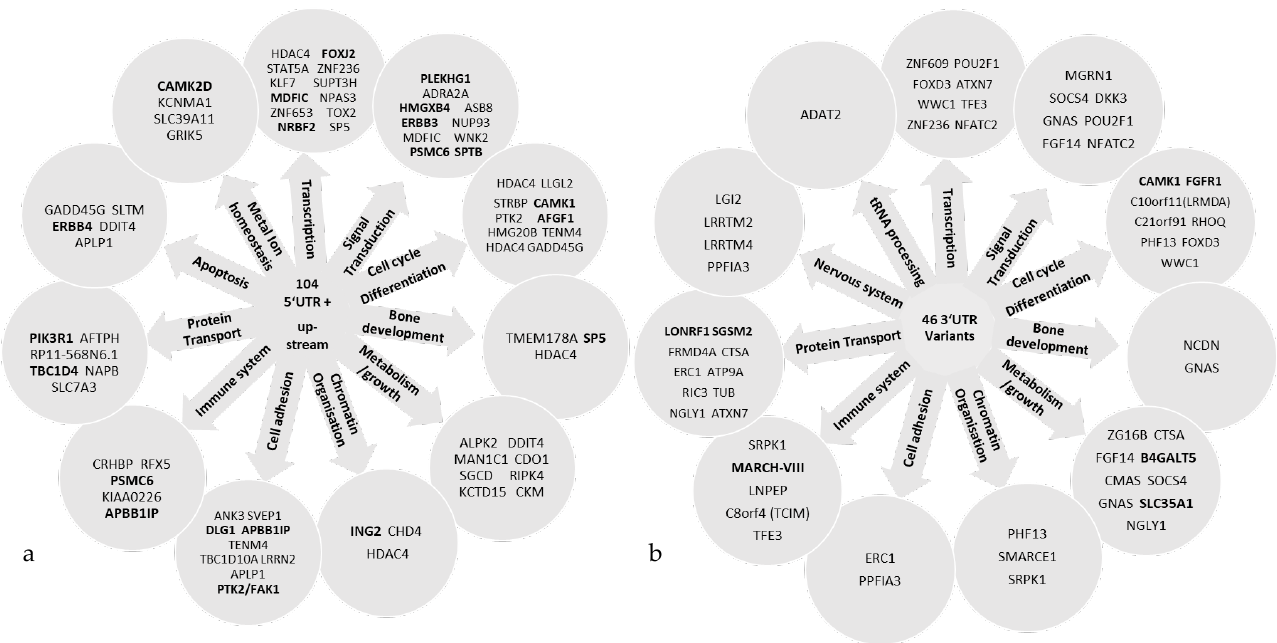
Figure 2. Key pathways highlighted by genes with variants in ( a ) 5′ UTR/upstream and ( b ) 3′ UTR analysis. Bold text indicates the genes with top variants.